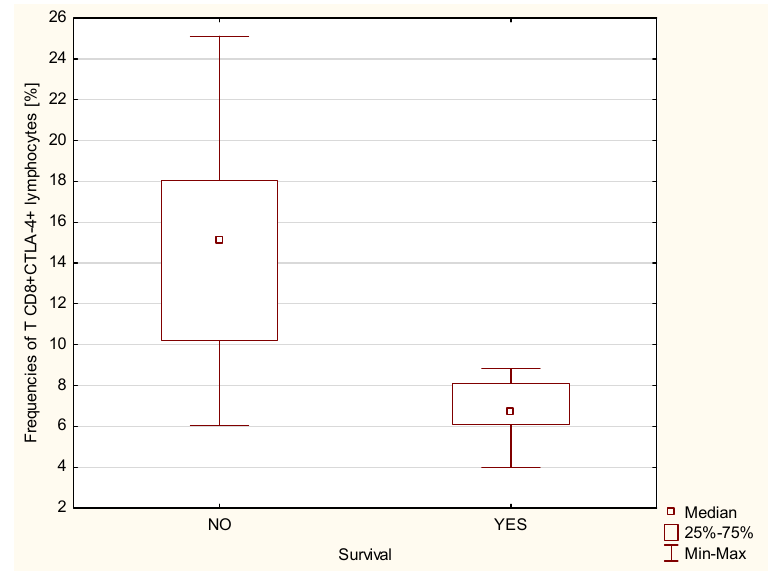
Figure 6. Percentage of CD8+CTLA4+ T lymphocytes in iPAH patients taking into account the survival of patients with iPAH ( p ≤ 0.001). The percentages of CD4+CTLA-4+ T cells correlated strongly positively with the severity of heart failure New York Heart Association (NYHA) Functional Classification (Spearman’s rank correlation r = 0.7077, p < 0.001, Figure 7).